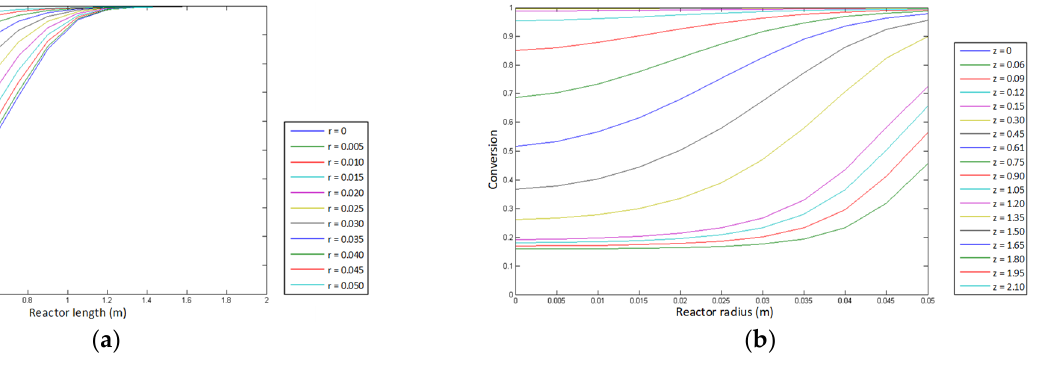
Figure 1. Graphical representation of the conversion profile of cyclohexanol to cyclohexanone: ( a ) Graphical representation of the conversion profile of cyclohexanol to conversion profile of cyclohexanol as a function of length for each placement point along the radius cyclohexanone: ( a ) conversion profile of cyclohexanol as a function of length for each place- of the reactor, and ( b ) conversion profile of cyclohexane as a function of radius for each position ment point along the radius of the reactor, and ( b ) conversion profile of cyclohexane as a function of longitudinal. Obtained from the data in Table A1. radius for each position longitudinal. Obtained from the data in Table